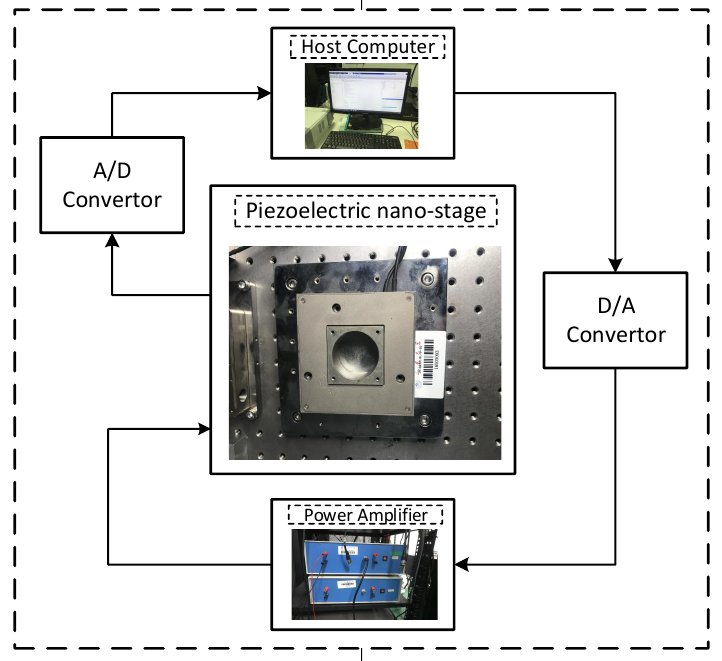
Figure 6. Experimental setup, piezo-actuated nano-stage connected to power amplifier and host computer with Matlab Realtime target, via 16 bit D/A and A/D, respectively.